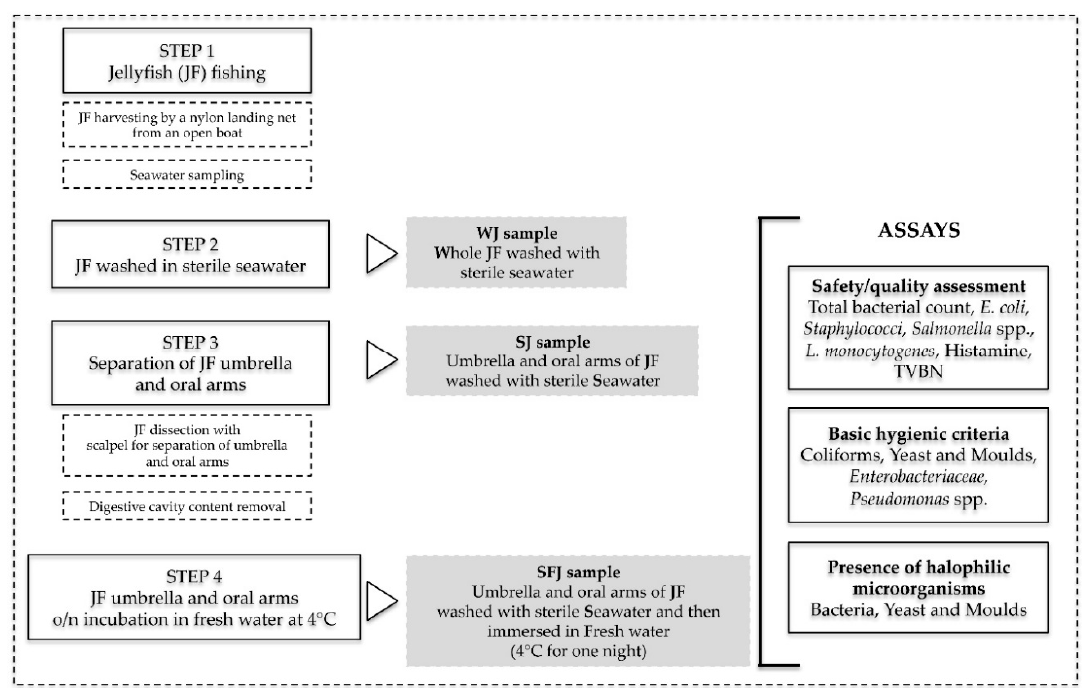
Figure 1. Diagram illustrating samples collection, preparation and analyses. TVBN: total volatile base nitrogen. WJ: whole jellyfish washed with sterile seawater. SJ: umbrella and oral arms of jellyfish washed with sterile seawater; SFJ: umbrella and oral arms of jellyfish washed in sterile seawater and then immersed in fresh water at 4 °C for one night.